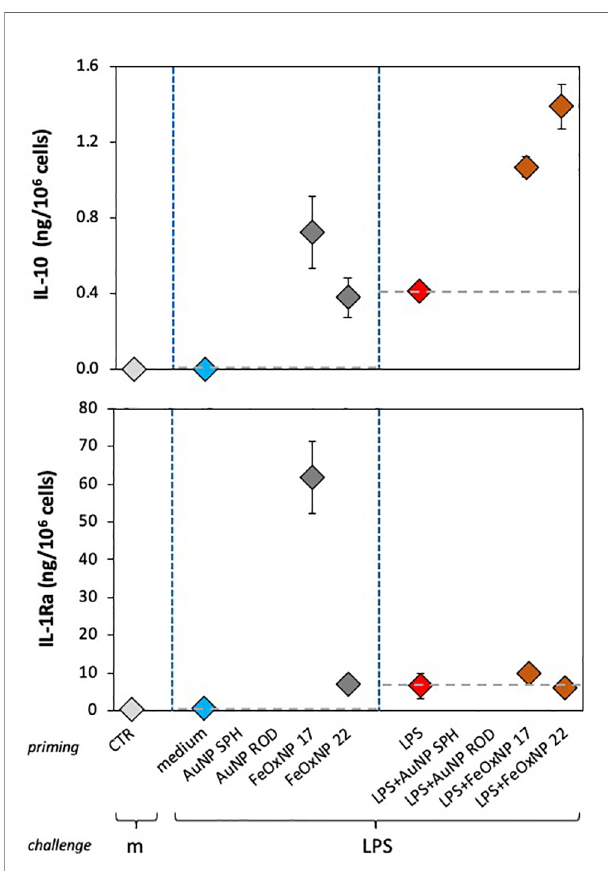
FIGURE 5 | Anti-in fl ammatory innate memory response of human monocytes from one individual donor, primed with FeOxNP alone or together with LPS. Human monocytes isolated from blood of one individual donor (donor 4, diamond symbols); were cultured for 24 h in culture medium alone or containing serum-precoated FeOxNP (2 µg/ml FeOxNP 17 and 2.7 µg/ml FeOxNP 22) alone or together with 1 ng/ml LPS (line priming in abscissa). Cells were then washed and rested for 6 days in the absence of stimuli, then challenged for 24 h in fresh medium alone or containing 5 ng/mL LPS (m and LPS in the abscissa line challenge ). The production of IL-10 (upper panel) and IL-1Ra (lower panel) was measured in the 24 h supernatants by ELISA (complete data shown in Figure 3 ). Horizontal dotted lines represent the reference values of cells primed with medium alone and cells primed with LPS in the two parts of each panel. The basal response of control cells (CTR), i.e. , primed or unprimed cells rested for 6 days and then exposed for 24 h to medium alone, is shown at the extreme left in each panel (grey symbols). Data are reported as mean ± SD of replicate determination from individual donors out of four tested (all shown in Figure 3 ). Statistical signi fi cance is as follows. Upper panel: medium vs. LPS, p < 0.05; medium vs . both FeOxNP, p < 0.05; LPS vs . LPS + FeOxNP, p < 0.05; FeOxNP 17 vs . LPS + FeOxNP 17, p < 0.05. Lower panel: medium vs . FeOxNP 17, p < 0.05; FeOxNP 17 vs . FeOxNP22, p < 0.05. All other relevant comparisons are not signi fi